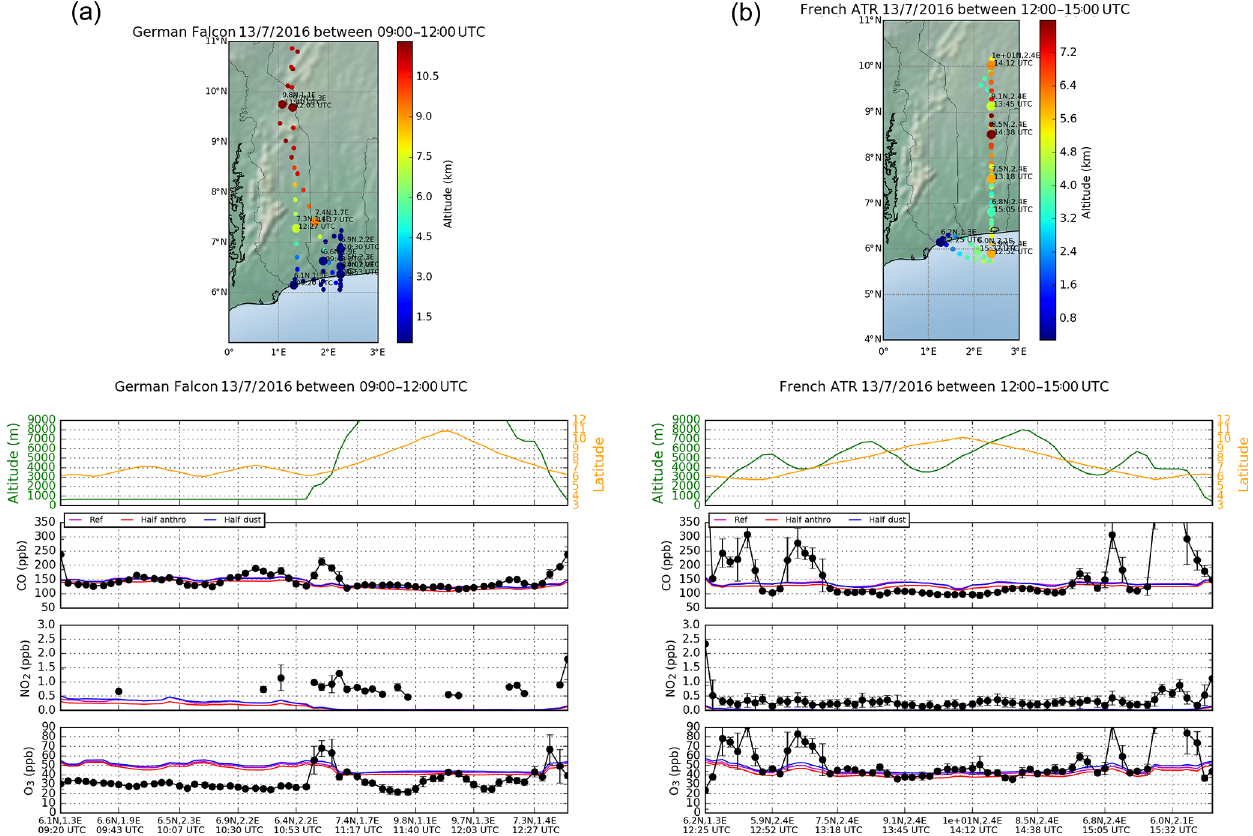
Figure 5. Model vs. aircraft measurements. Top panels: flight tracks of the DLR (a) and ATR (b) aircraft on 13 July 2016. The top figures show the altitude (a.g.l.) and the latitude during the flight. The other panels present the concentrations of CO (ppb), NO 2 (ppb) and O 3